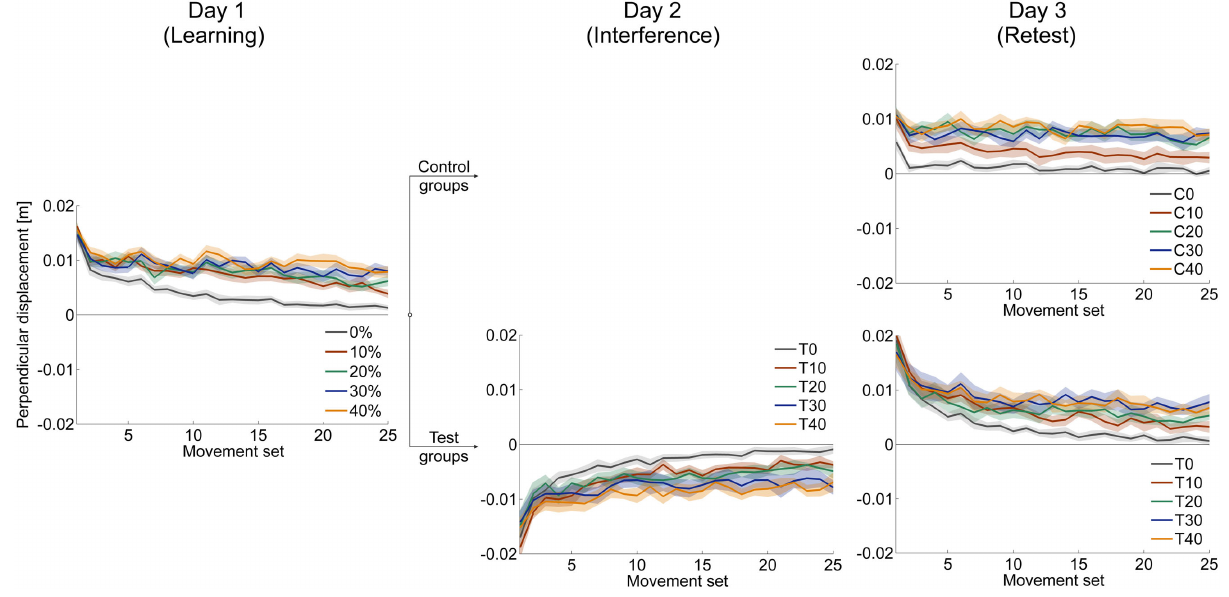
disturbance of force field A (force field B). On all three days, subjects were able to adapt to the changed dynamic conditions leading to decreased errors. All data is presented as mean values ± 95% confidence intervals.